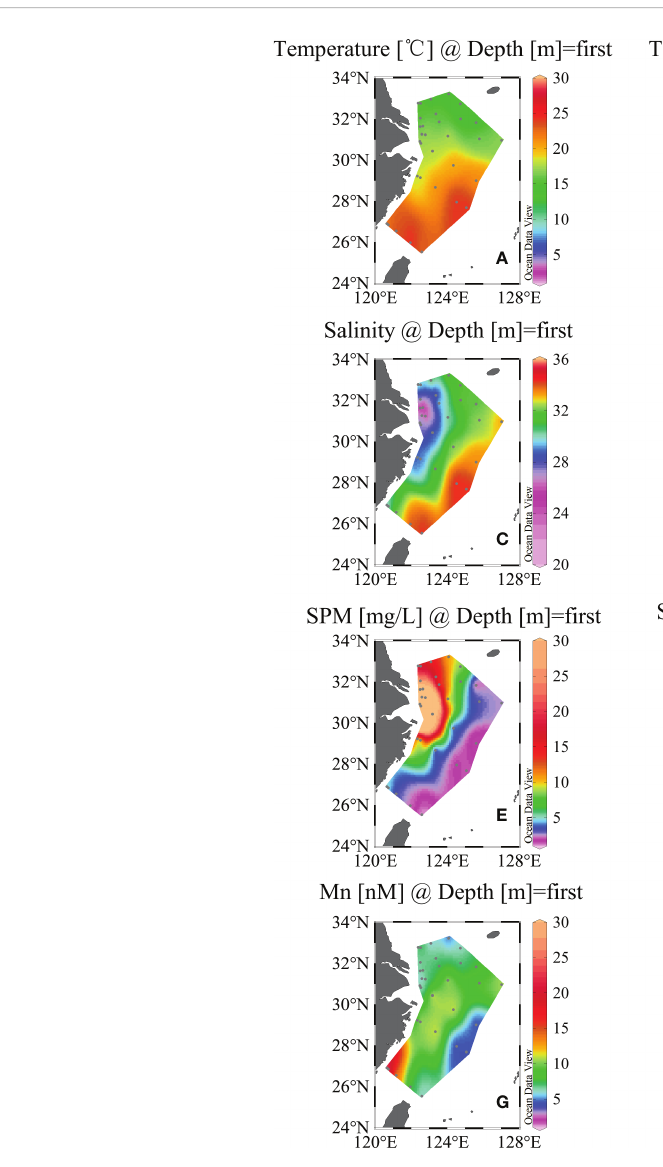
FIGURE 3 Horizontal distributions of temperature (°C), salinity, SPM (mg/L), and dissolved Mn (nM) in the surface (A, C, E, G) and the bottom layers (B, D, F, H) in the East China Sea in May